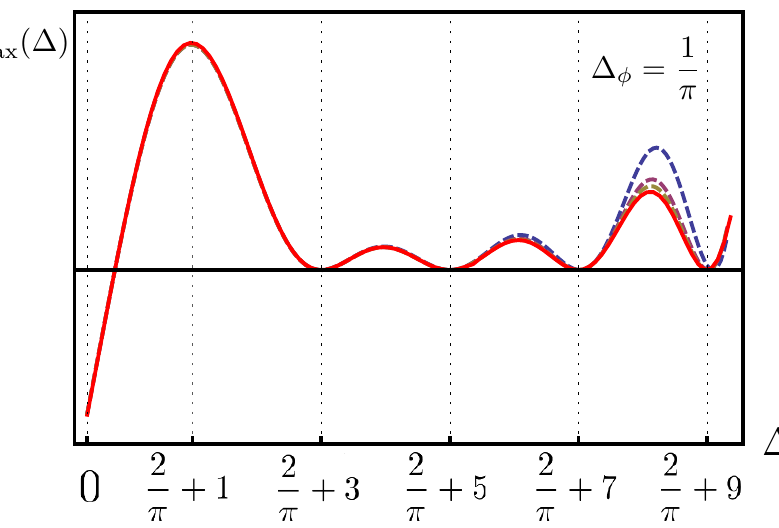
Figure 5 . OPE maximization functional at (cid:1) (cid:30) = 1 =(cid:25) . The three dashed curves which are almost entirely overlapping are the numerical results obtained using JuliBootS [15, 50] with N = 104 ; 184 and 264 derivatives. As the number of components is increased, the functional action rapidly converges to the red curve, with double zeros for (cid:1) = 2 (cid:25) (cid:0) 1 + 2 n + 1 with n (cid:21) 1. This curve in turn was obtained by acting with the combination of logarithmic and normal functionals that decays as (cid:24) z (cid:0) 4 as z ! 1